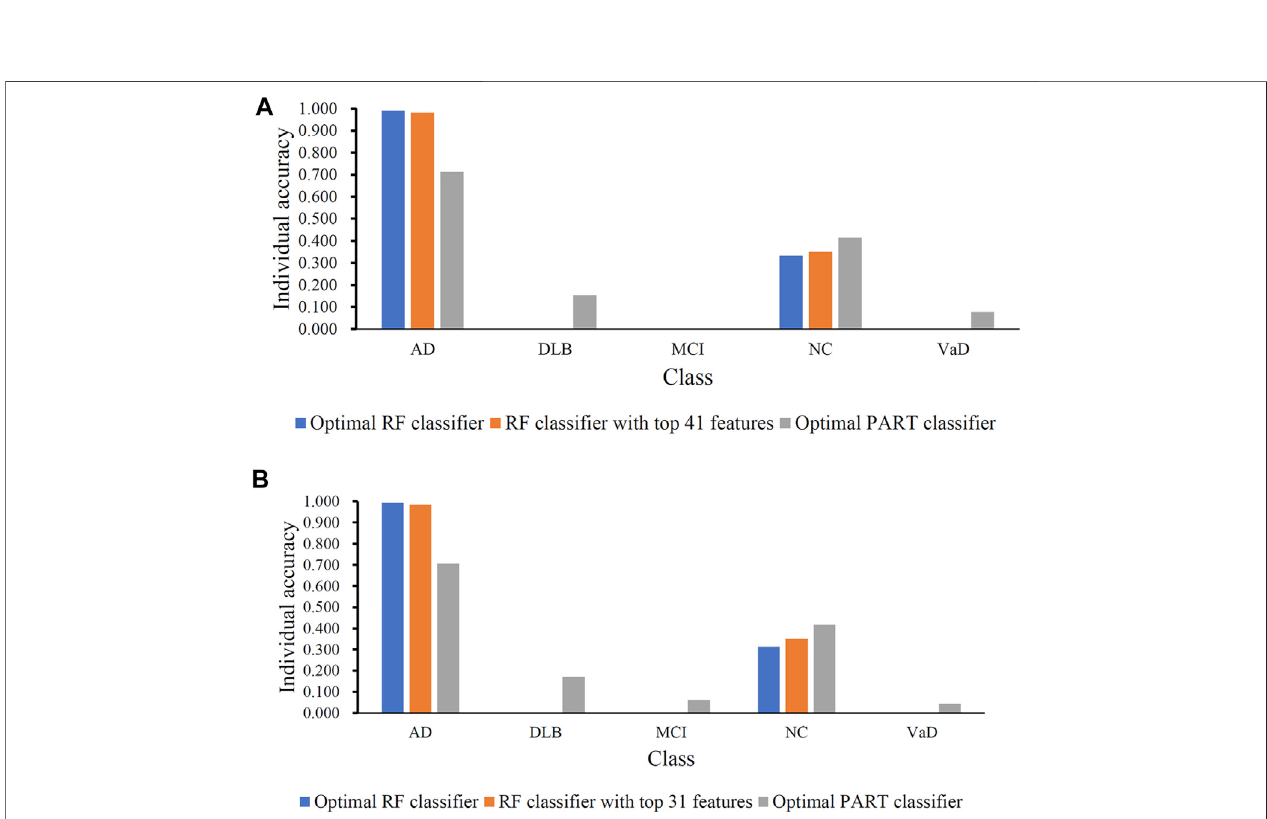
FIGURE6| PerformanceofthekeyRFandPARTclassi fi erswithoutSMOTE. (A) .Classi fi ersobtainedbyusingmRMRfeaturelist; (B) .Classi fi ersobtainedbyusing MCFS feature list. AD, VaD, DLB, MCI, and NC stand for Alzheimer ’ s disease, Vascular dementia, Dementia with Lewy bodies, Mild cognitive impairment and Normal control,